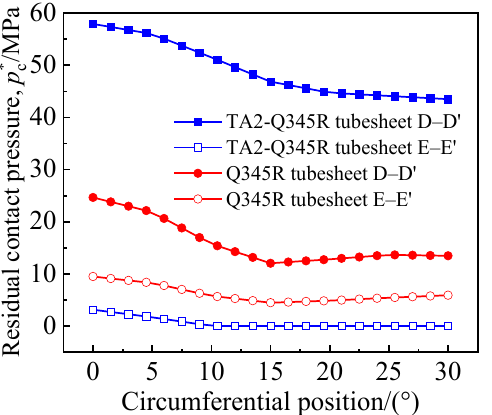
Figure 8. Circumferential distribution of residual contact pressure of Q345R tubesheet and TA2-Q345R clad tubesheet.